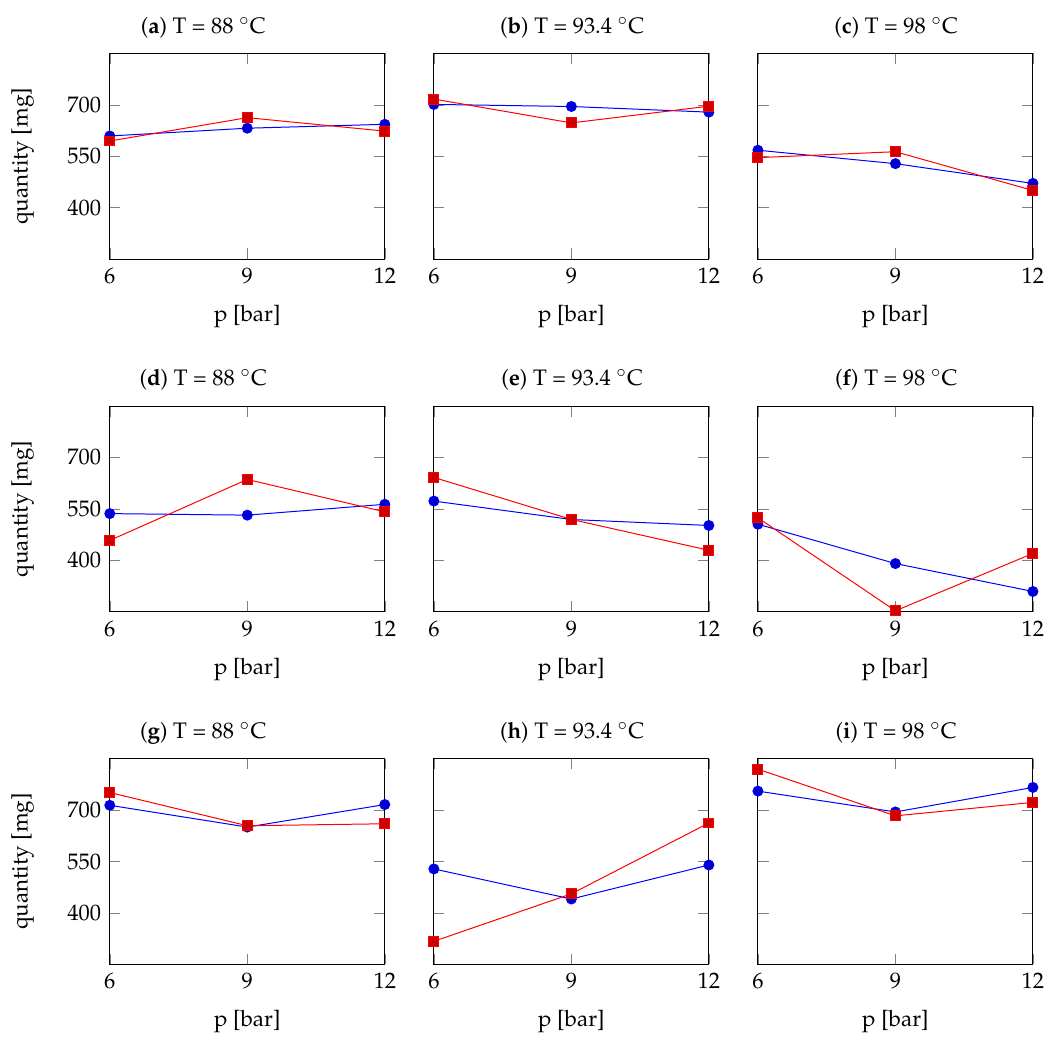
Figure 6. Comparison between the citric acid extracted through numerical simulations (blue profile with circles) and laboratory measurements (red profile with squares), with different inlet water temperatures and pressures and different grain size of Arabica coffee powder. Figures ( a – c ) show the results of optimal granulometry, Figures ( d – f ) of coarse granulometry and Figures ( g – i ) of fine